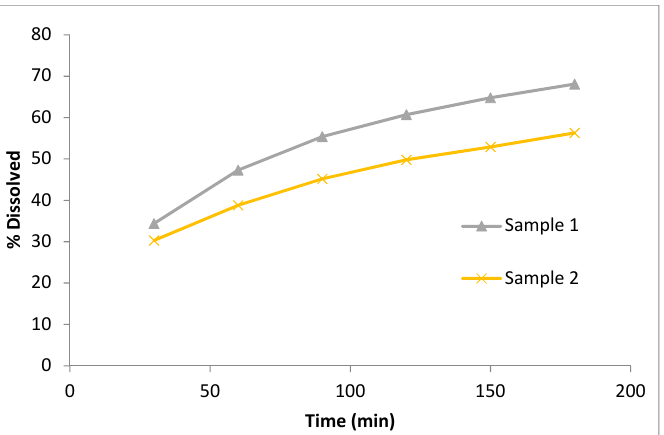
Figure 11. Non sink dissolution profiles for ASD of samples in fasted media.